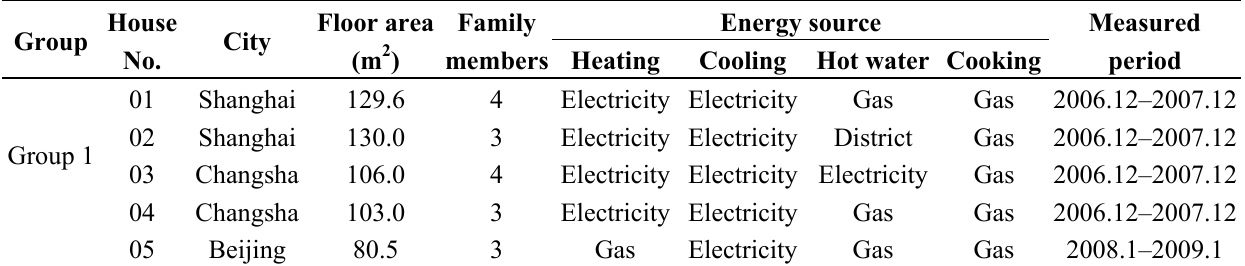
Table 1. Houses of the